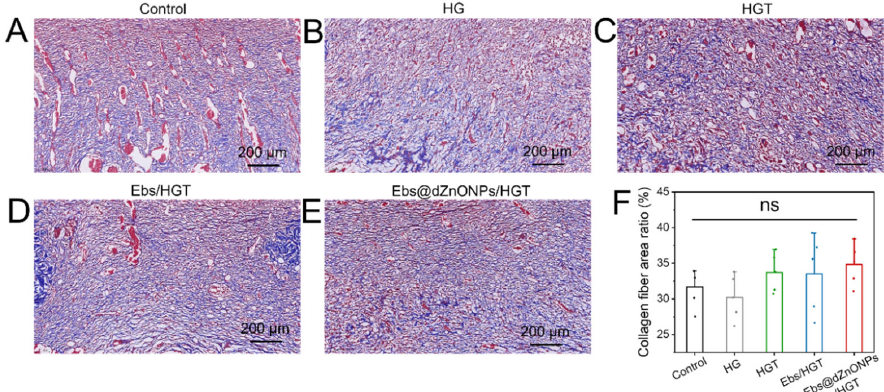
Figure 8. Results of Masson’s trichrome staining after 7 days of treatment. ( A ) Blank group, ( B ) HG hydrogel group, ( C ) HGT hydrogel group, ( D ) Ebs/HGT hydrogel, ( E ) Ebs@dZnONPs/HGT hydro- gel, ( F ) Quantitative analysis of collagen deposition area. Data are presented as mean ± standard ( n = 3) .